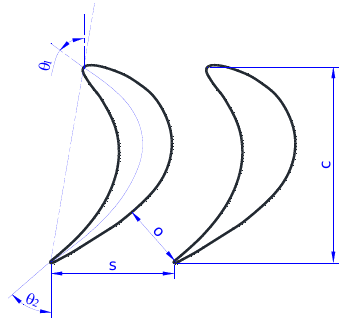
Figure 2. Main geometric blade parameters with relative